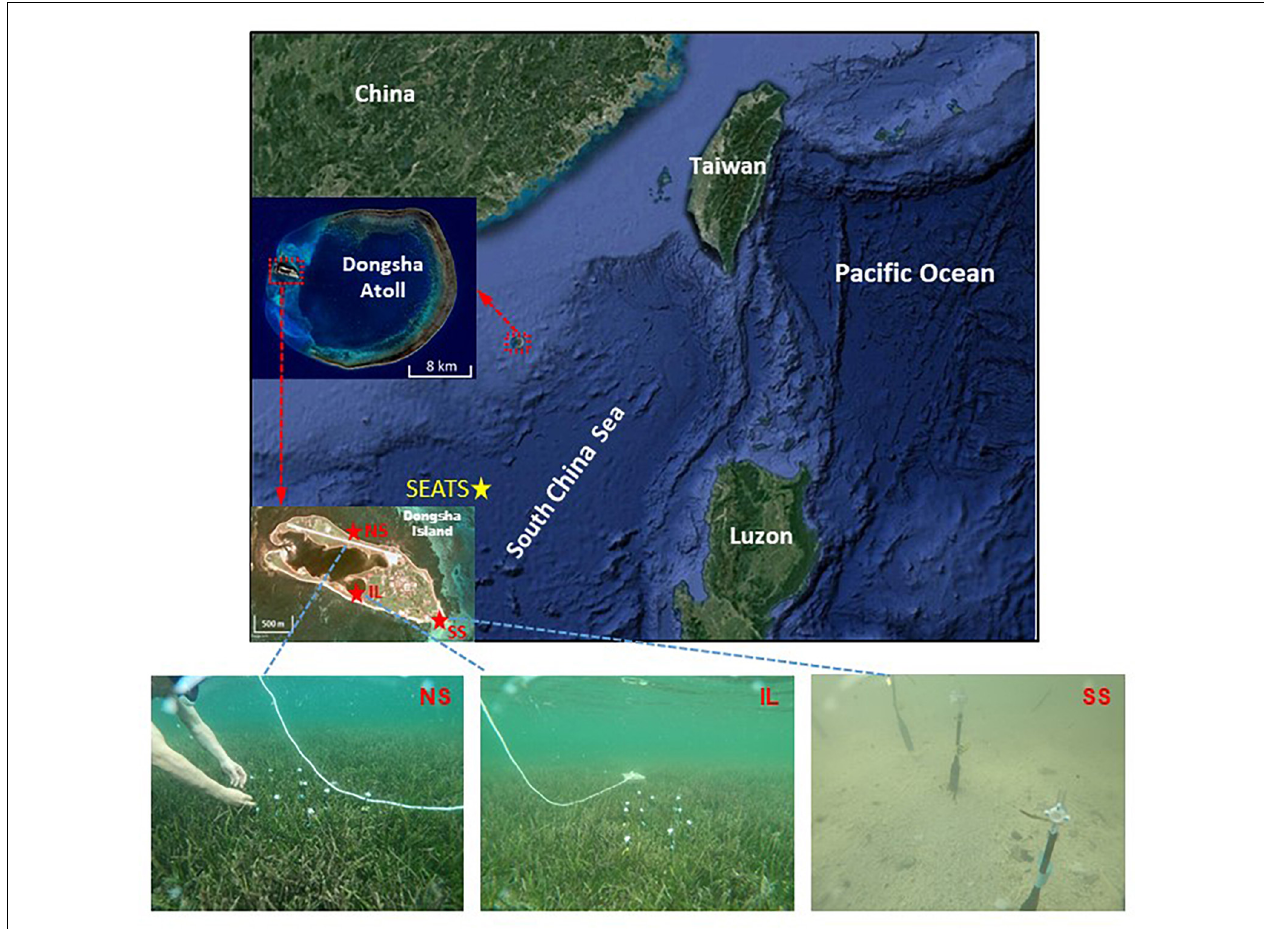
FIGURE 1 | Map showing the locations of Dongsha Atoll, Dongsha Island, and the sampling sites around Dongsha Island (upper panels) and photos showing the porewater sampling sites on the northern shore (NS), in the inner lagoon (IL), and on the southern shore (SS) (lower panels). The yellow asterisk indicating the location of the SouthEast Asian Time-series Study